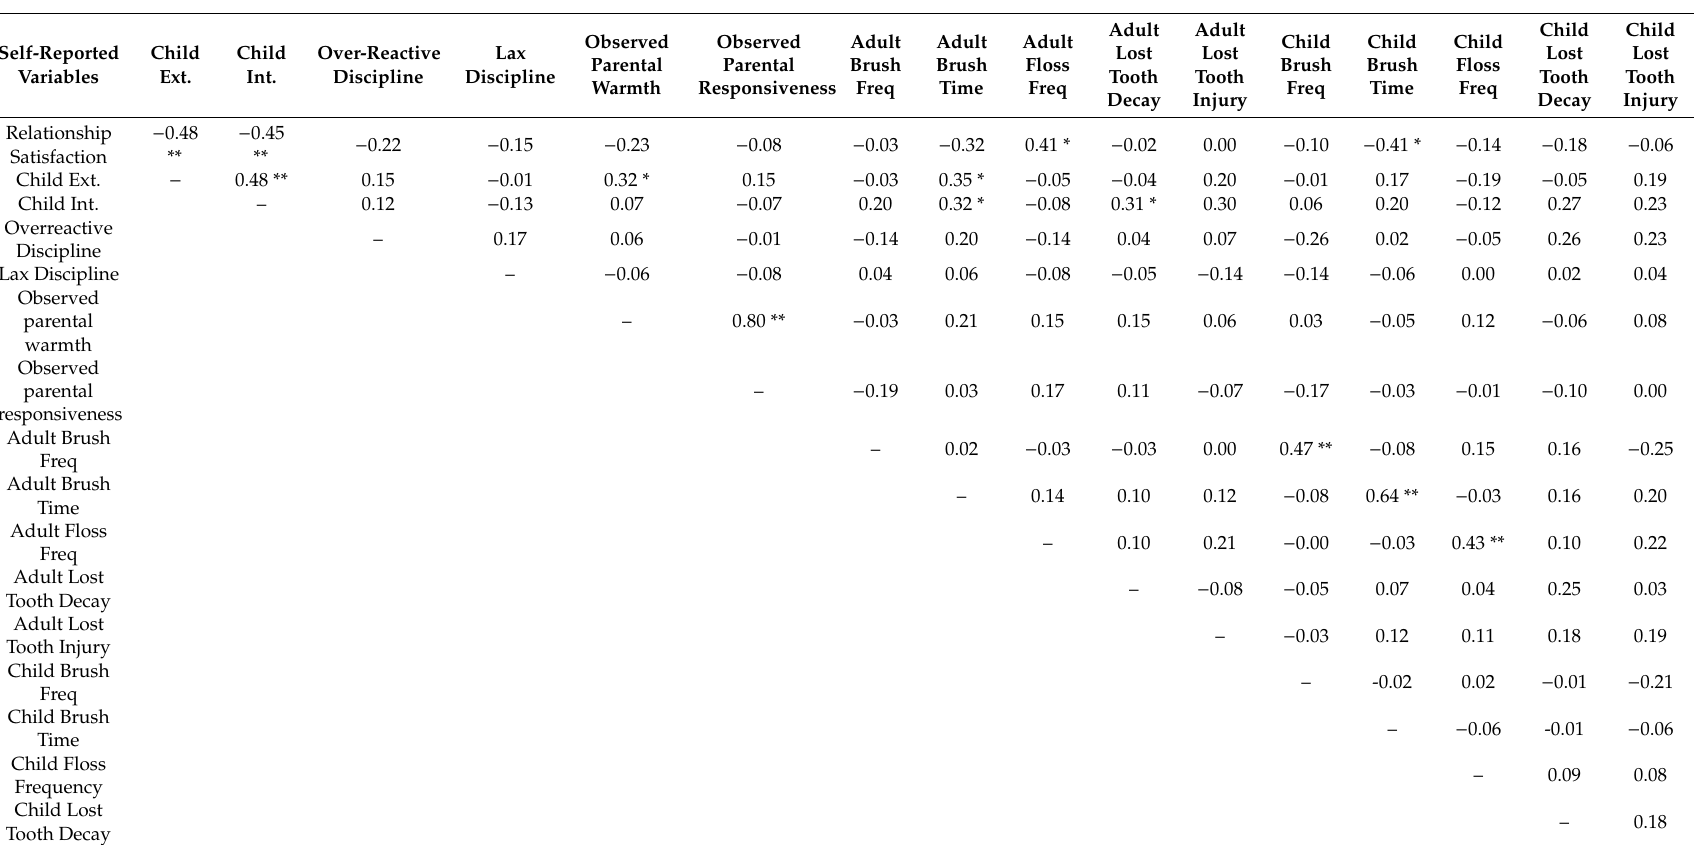
Table 3. Correlations Among Study 2